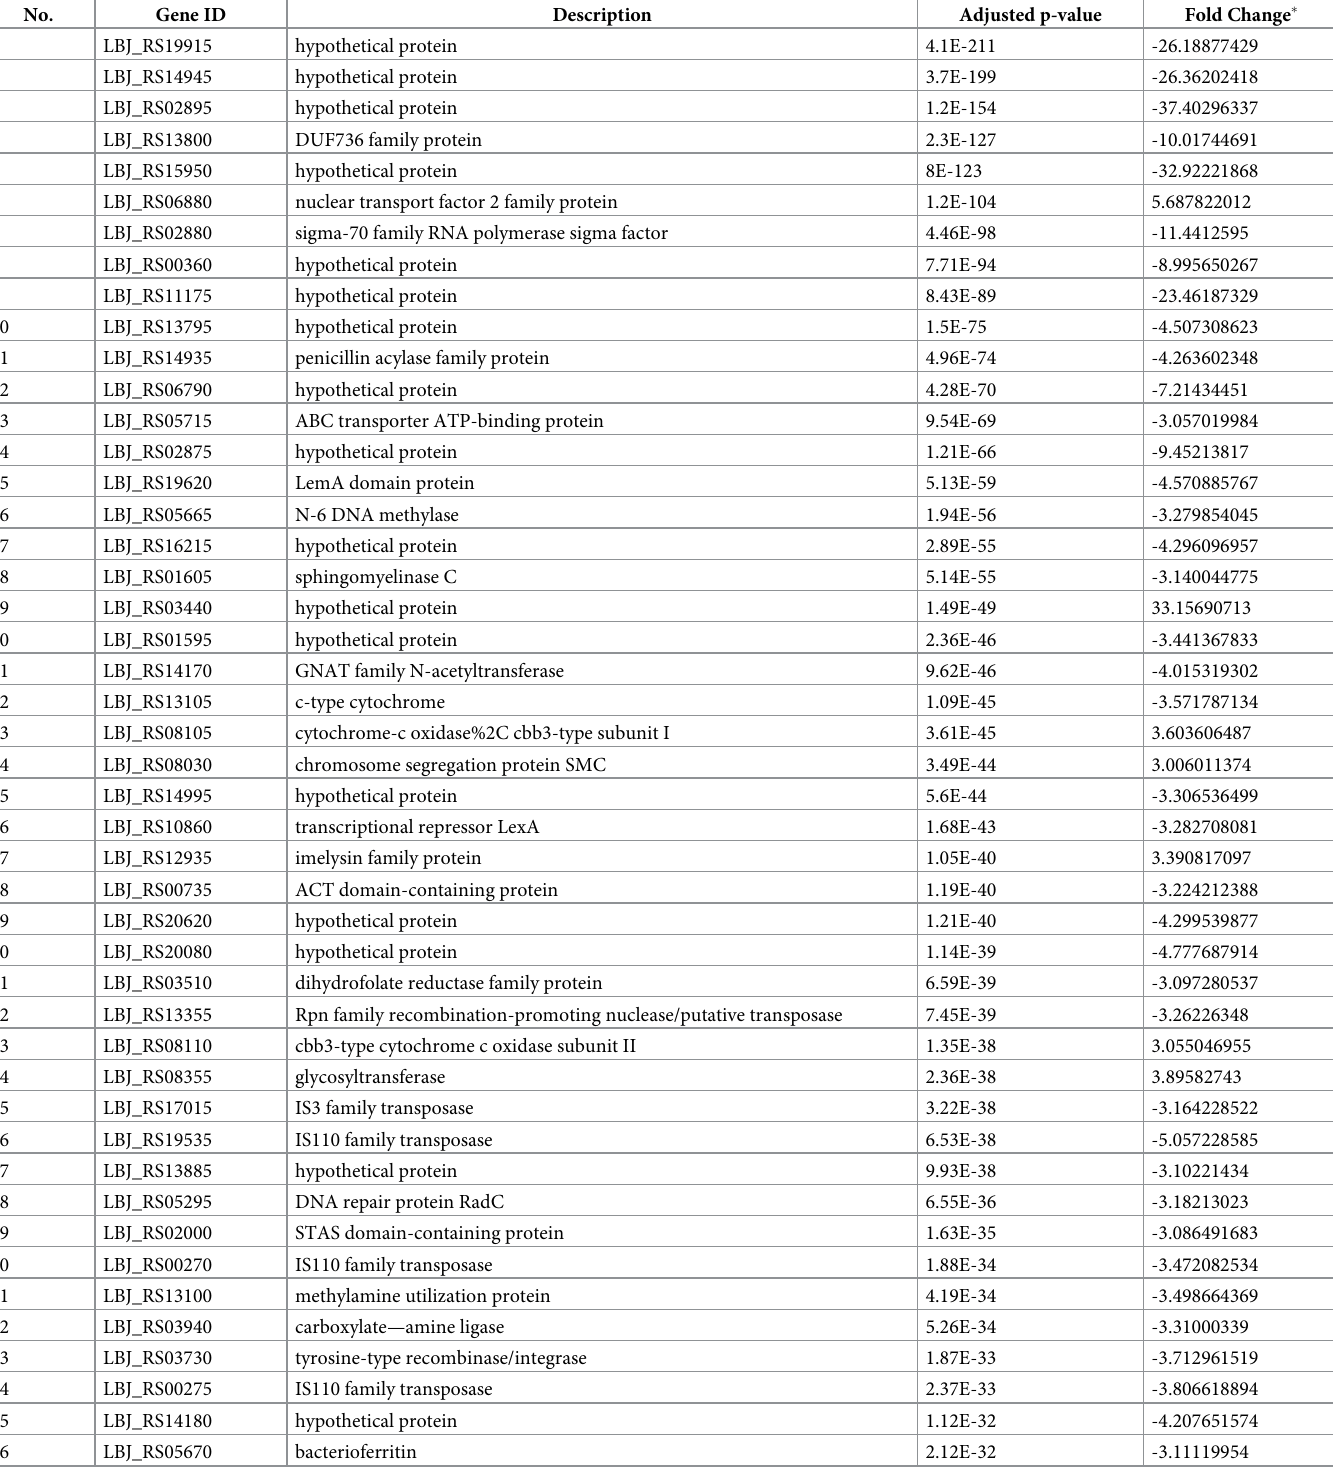
Table 4. The fifty most significantly differentially expressed genes between JB197 grown at 37˚C and 29˚C. All genes are relative to the JB197 reference genome and annotated by the JB197 gene ID. � Positive and negative fold change values indicate higher expression at 37 and 29˚C, respectively.